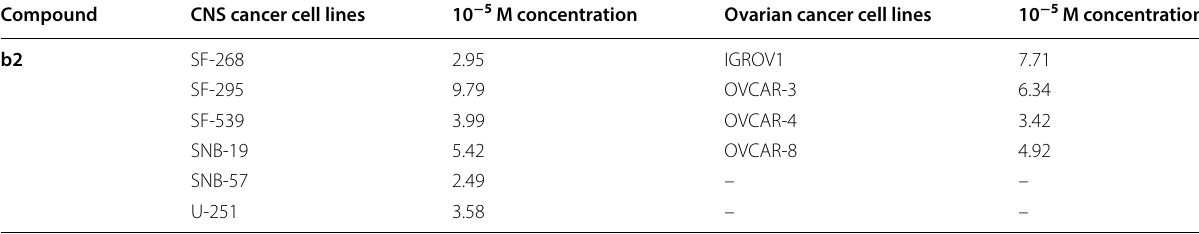
Table 16 Anticancer activity results of most active compound b2 Compound